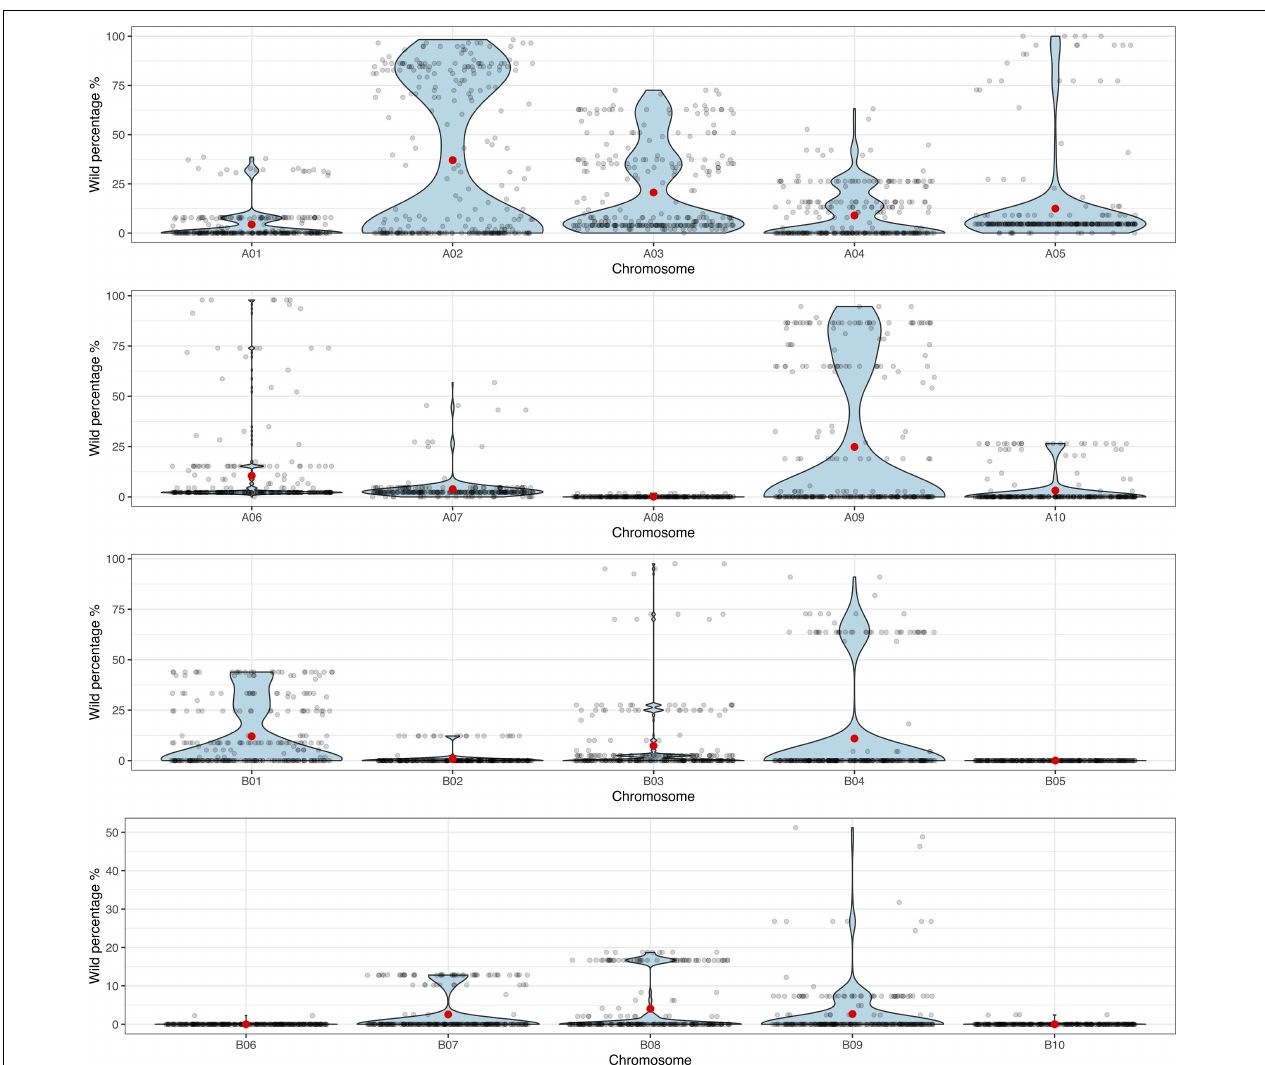
FIGURE 3 | Violin plots for the proportion of wild genome (%) (y-axis) in each of the 10 A- and 10 B-subgenome chromosomes (x-axis) for the 271 BC 3 F 1 lines. Black dots indicate each individual BC 3 F 1 , and red dots indicate the mean.